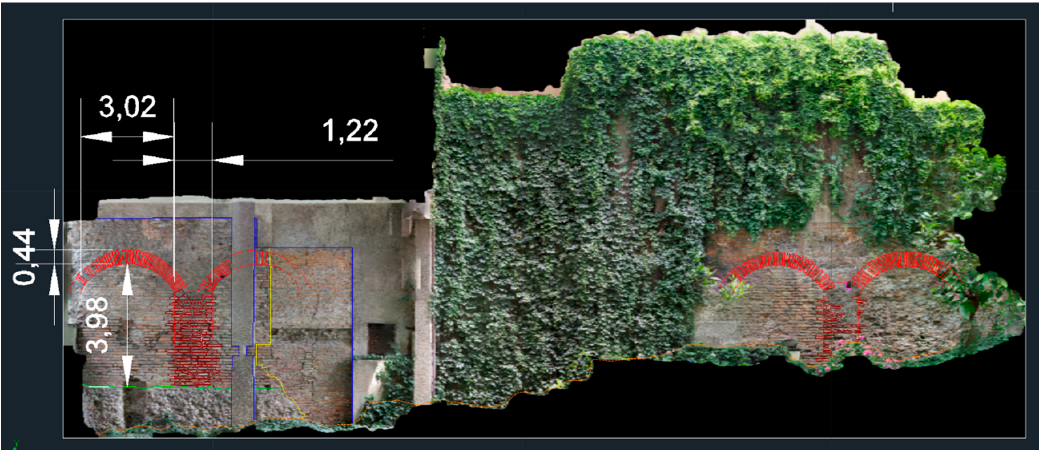
Figure 4. Documentation of the main portion of the circus outer wall still standing through an orthoimage, providing the measurement of the arches supporting the audience seats.